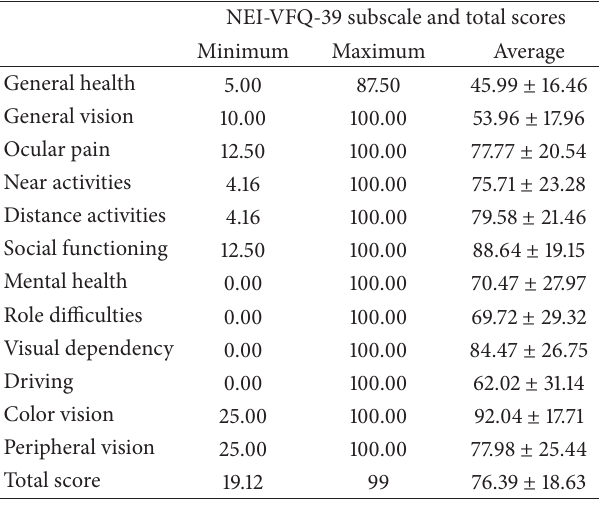
Table 5: NEI-VFQ-39 subscale and total scores of